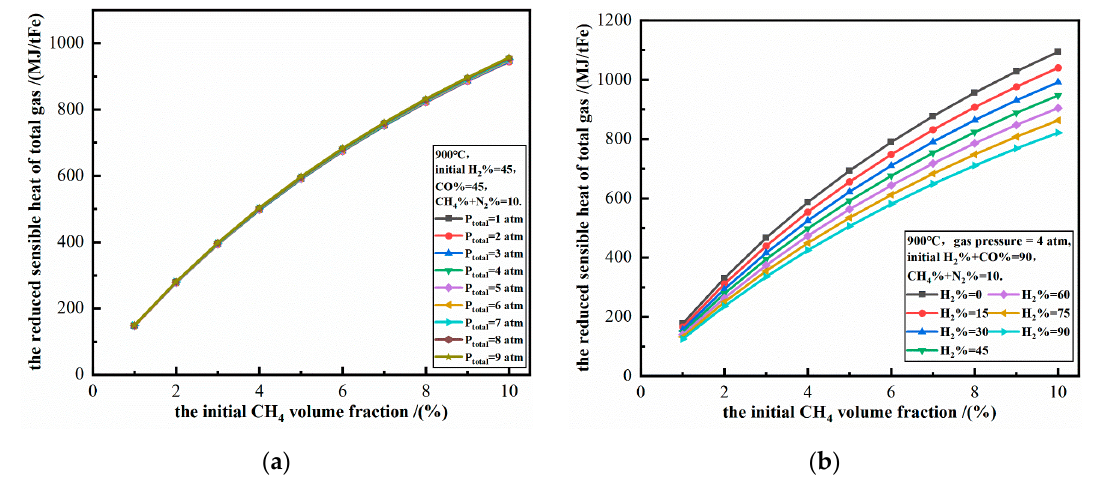
Figure 11. The relationship between the reduced sensible heat of total gas and the initial CH 4 volume fraction at 900 °C. ( a ) H 2 % = 45, CO% = 45, total pressure is 1–9 atm; ( b ) H 2 % + CO% = 90, total pressure is 4 atm.